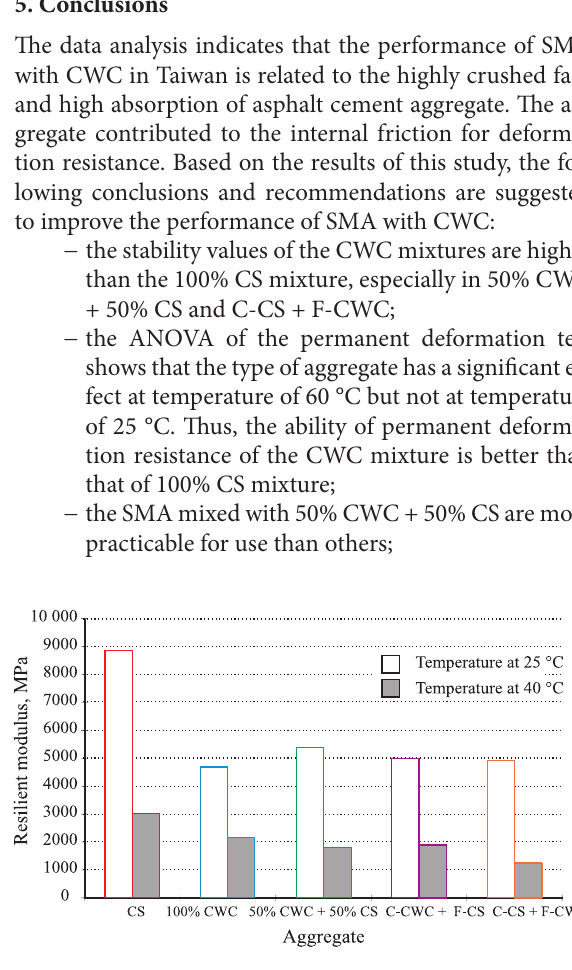
Fig. 2. Rutting test results at 60 °C